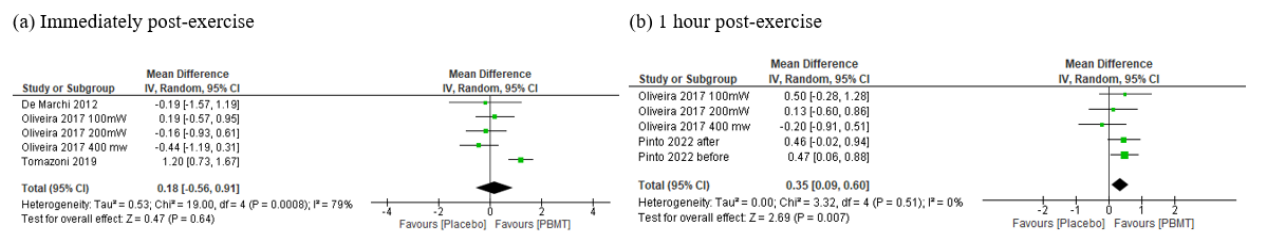
Figure 3. Meta-analysis of CAT activity immediately ( a ) and 1 h ( b ) post exercise. PBMT — photobiomodulation, IV — inverse variance, CI — confidence interval. Table 4. Mean difference and 95% confidence interval between changes of PBMT versus placebo at time-points that were not meta-analyzed.